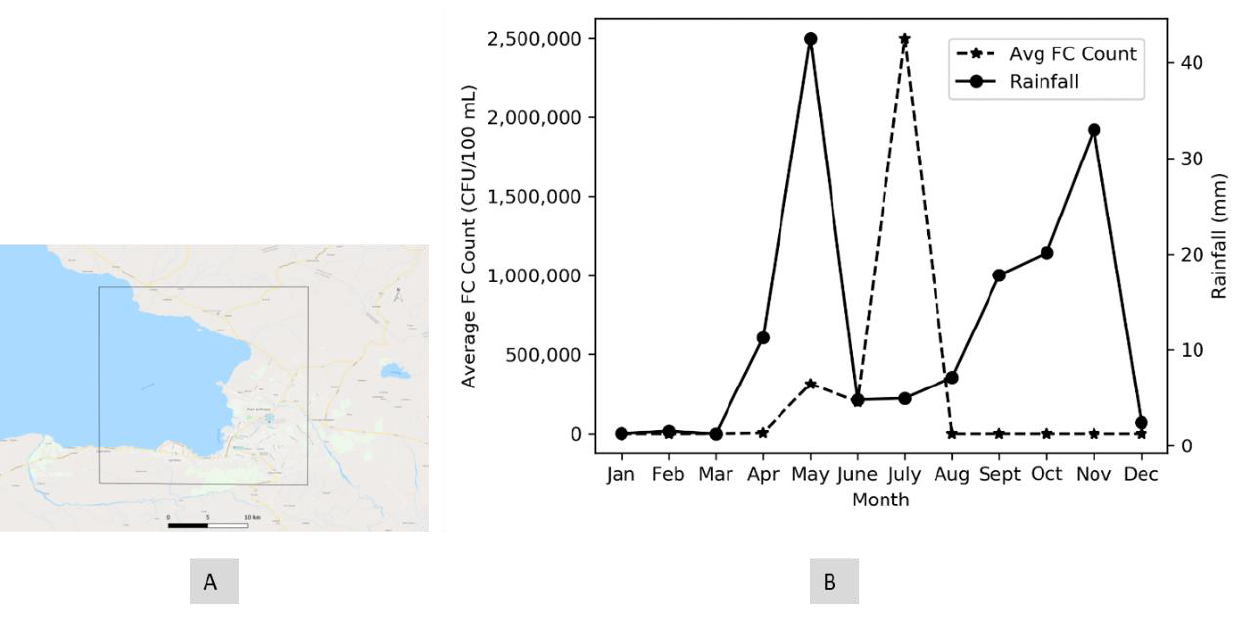
Figure A1. FC count variation with respect to rainfall. ( A ) Rainfall grid extent; ( B ) Rainfall and average FC count for all months in 2017. Table A1. Monthly FC count for 15 water point samples of type “Pipe/Cistern” for the year 2017 . WPoint Jan. Feb. Mar. Apr. Jun. Aug. Dec.